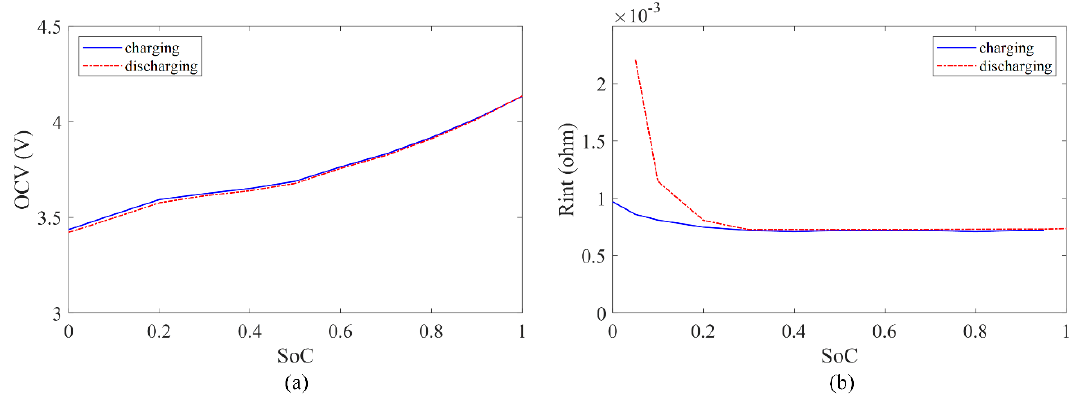
Figure 2. Battery characteristics. ( a ) Open circuit voltage. ( b ) Internal resistance.